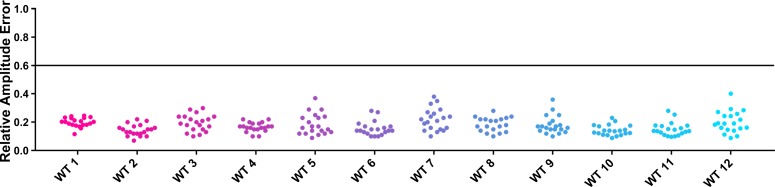
RAE distributions of control plants in U-box experiments.Values presented are the RAE of each individual control plant. The black line represents the standard RAE cutoff of 0.6.